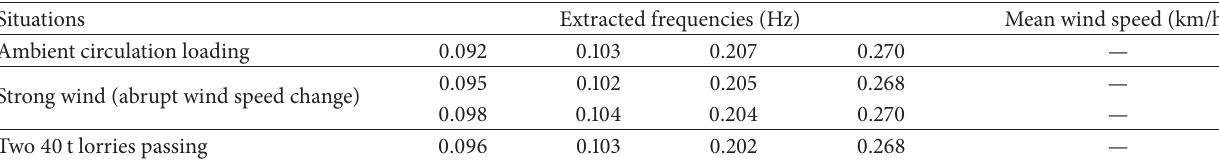
Table 3: Vibration frequencies extracted from height GPS measurements ( 𝑈 direction of